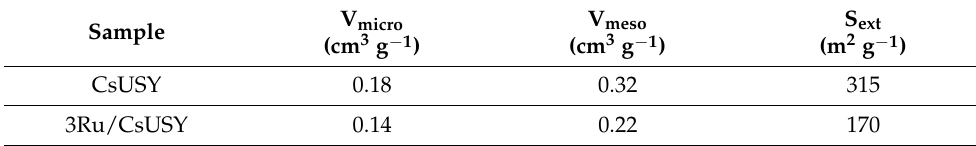
Table 1. Textural properties of the studied samples obtained by N 2